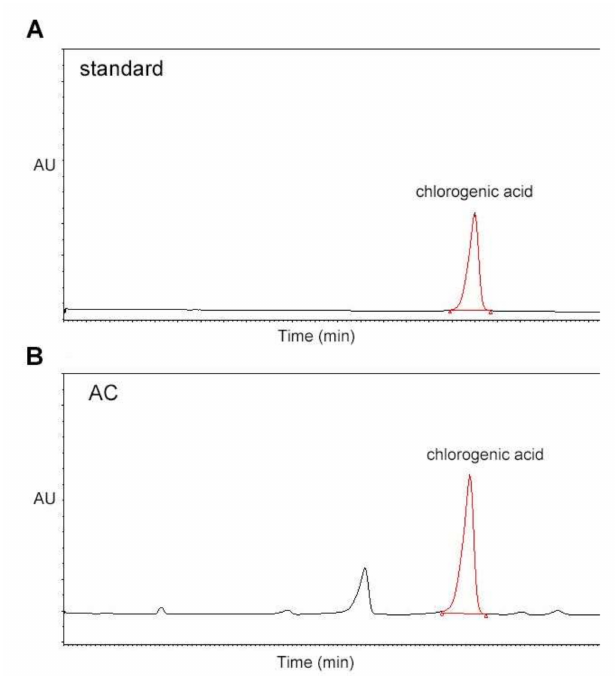
Figure 1. HPLC analysis of chlorogenic acid in the AC extract. HPLC was performed to determine the composition of chlorogenic acid in AC. The contents of chlorogenic acid were analyzed in ( A ) standard solution and ( B ) AC water extract. HPLC, high-performance liquid chromatography; AC, Aralia continentalis kitagawa